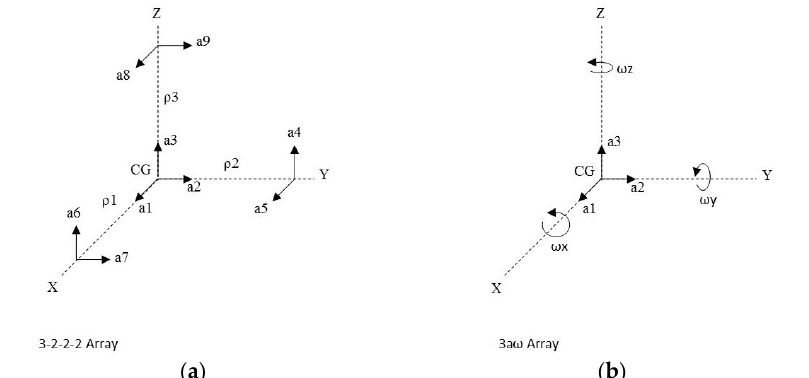
Figure 1. Schematic showing relative arrangement of ( a ) 3-2-2-2 and ( b ) 3aω sensor arrays relative to the headform center of